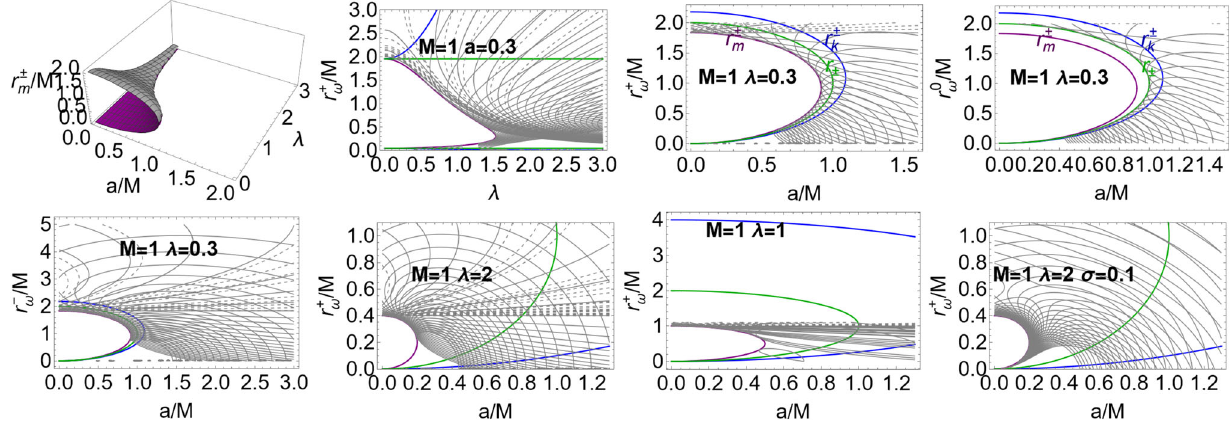
θ = π/ 2 and σ ≡ sin θ 2 = 0 . 1 (bottom right panel). The radii r ± (blue curves), are shown, where the radius r + κ defines the wormhole throat connecting two asymptotically flat regions. The radii r ± m (purple curves) and Kerr BH horizons r ± (green curves) as envelope surfaces of the metric bundles are also shown